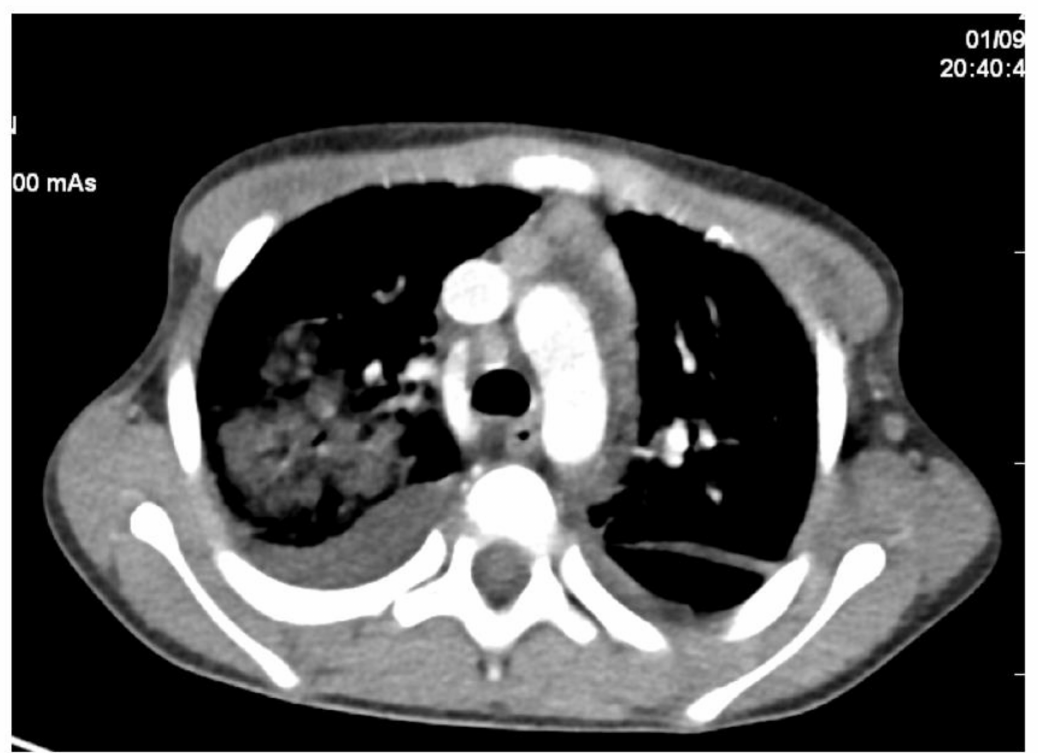
Figure 8. Thoracal angioCT shows important consolidation of the right lung, posterior right pleu- ral